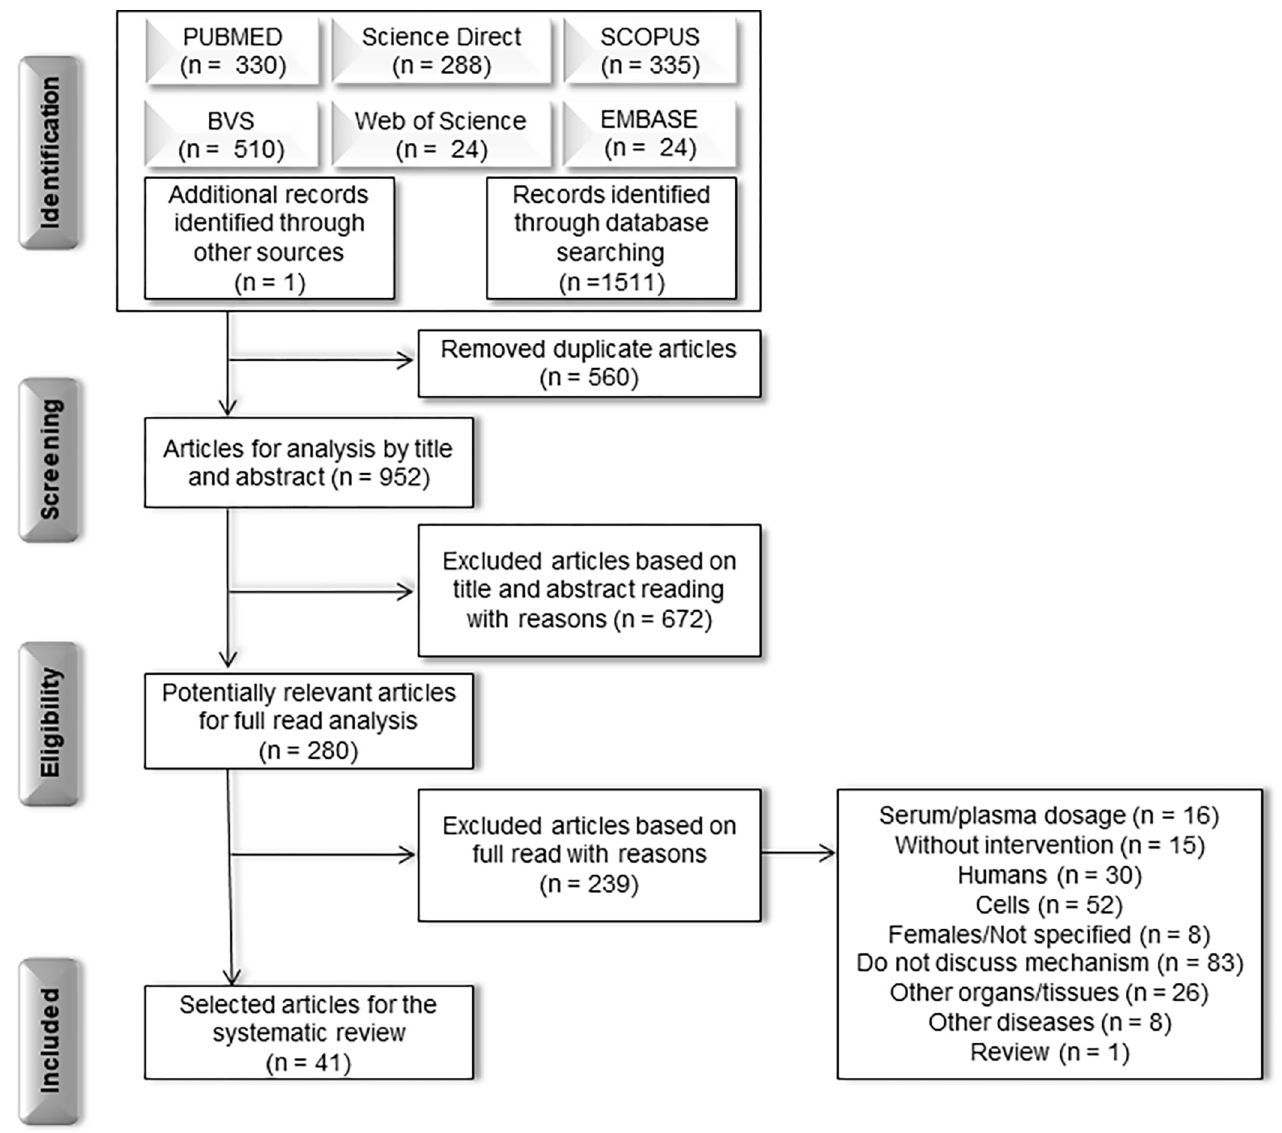
Fig 1. Flowchart for selecting articles based on Preferred Reports for Systematic Reviews and Meta-Analysis (PRISMA) to answer the question: What are the mechanisms of action of anti-inflammatory agents in adipose